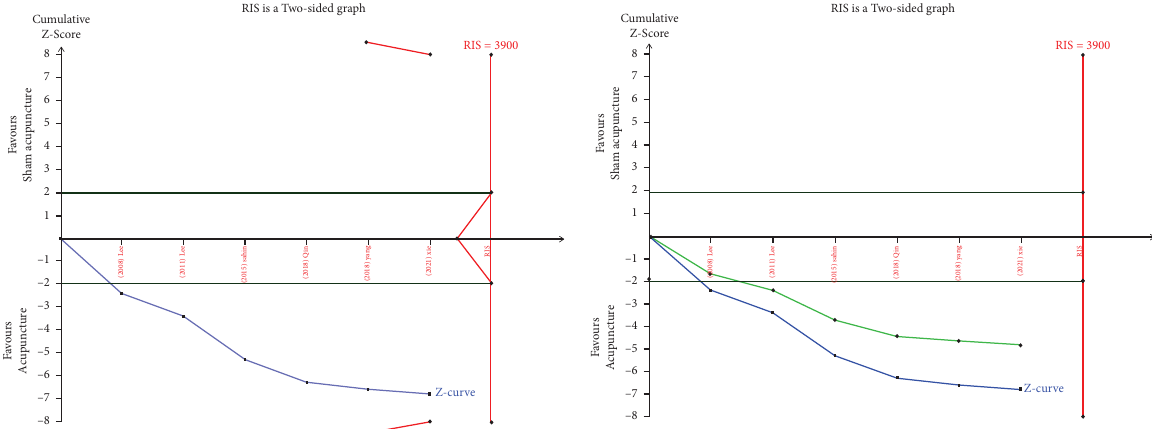
Figure 5: TSA on comparison of acupuncture verse sham acupuncture in efcacy rate. Te straight black line represents the conventional statistical boundary of P � 0 . 05. Te blue line indicates the cumulative z -score of the meta-analysis. Te red line indicates the TSA boundary. Te green line represents the Z -curve after the penalty statistic. RIS represents the required size of